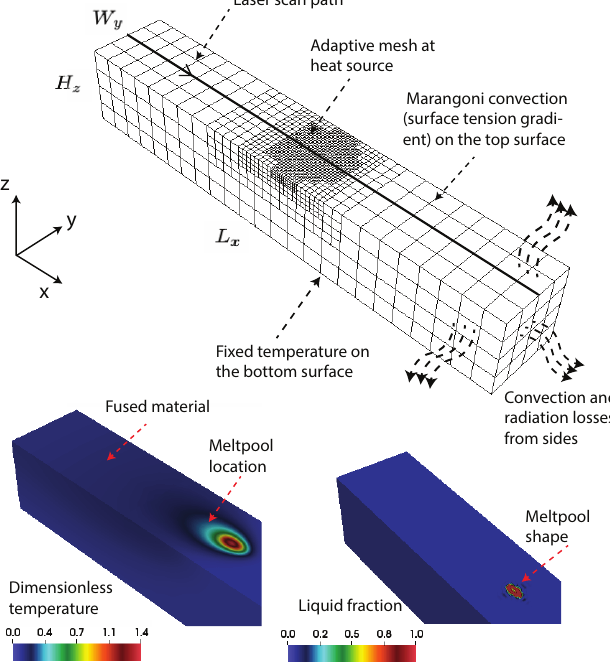
Figure 2. Schematic of the 3D finite element (FE) computational domain indicating the laser scan path and the relevant boundary conditions. Shown also is the underlying adaptive mesh that evolves with the location of the heat source. Representative dimensionless temperature profile and location of the meltpool obtained from the FE simulation of SS316 alloy AM are shown. The numerical parameters and material properties used in this simulation are given in Section 2.3 and in the Supplementary